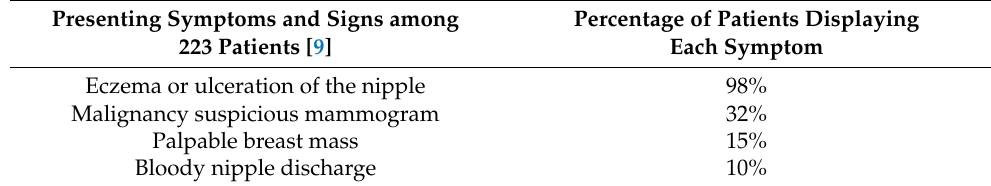
Figure 2. Images A-F show progression of mammary Paget’s disease over a 2-year period. Table 1. Presenting symptoms of MPD.